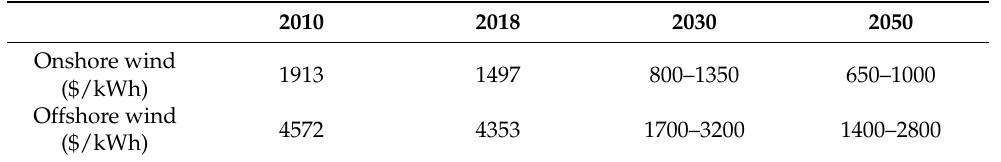
Table 2. Total installation cost * [2].